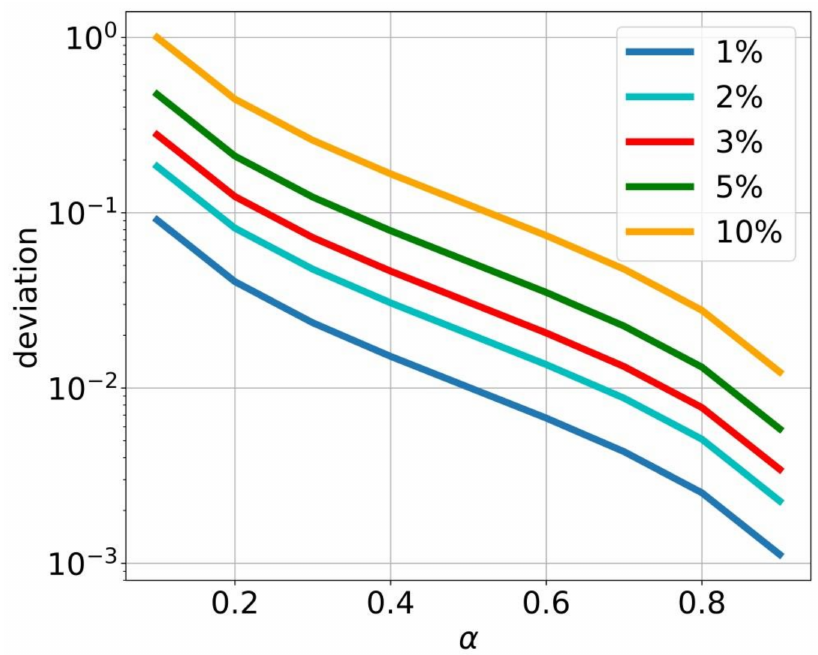
Figure 4. Suitability of α as the node performance degradation